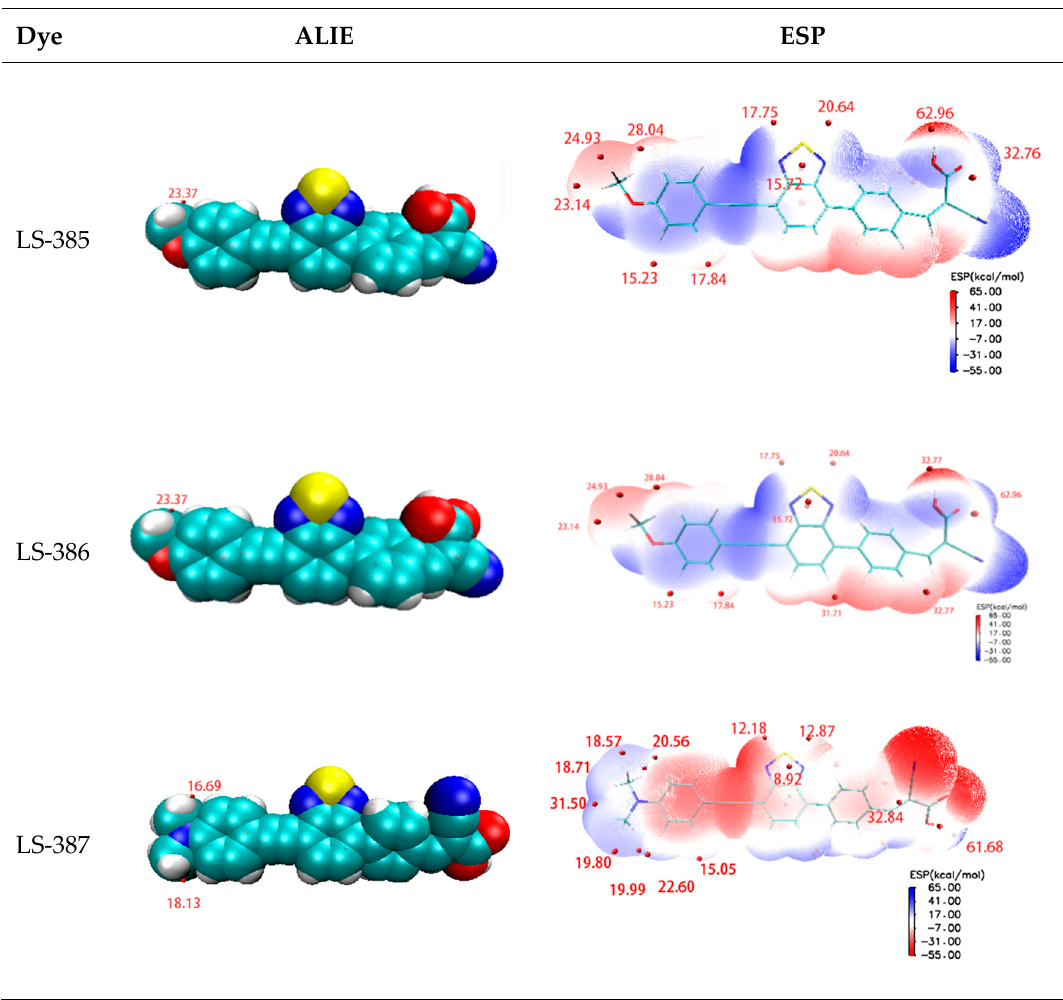
Figure 7. Graphical representation for minima of ALIE on VMD surface and local maxima of ESP on VMD surface of the dye cations of LS-385 + , LS-386 + , and LS-387 + . The extrema ALIE (in eV) and ESP (in kcal/mol) points near to the donor regions are marked.